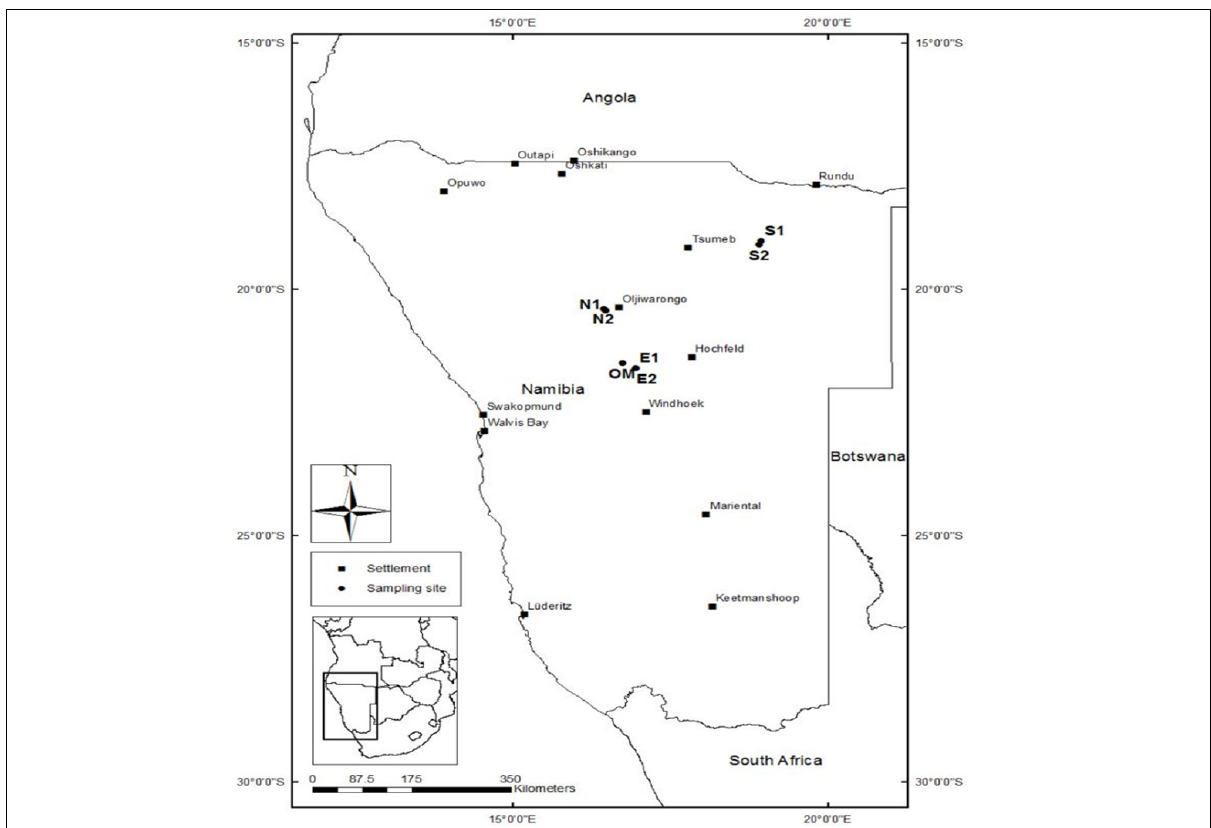
Figure 2: Location of sample sites in northern Namibia. Physical and chemical properties of the mound surface, mound interior, topsoils and subsoils. Values are presented as means and standard errors ( n =7). Letters (a,b,c) indicate significant differences between values in a row ( p <0.05). Statistical analyses were conducted as follows: linear mixed models using the ‘lme4’ package 11 in R 12 ; sampling site was assigned as a random intercept to test the differences in soil properties within and not across sites; model residuals were inspected for normality and plotted against independent variables to test for linearity, ensuring no violation of linear mixed model assumptions; and Tukey’s post-hoc tests were applied to identify significant differences between treatment means. Mound Topsoil Subsoil